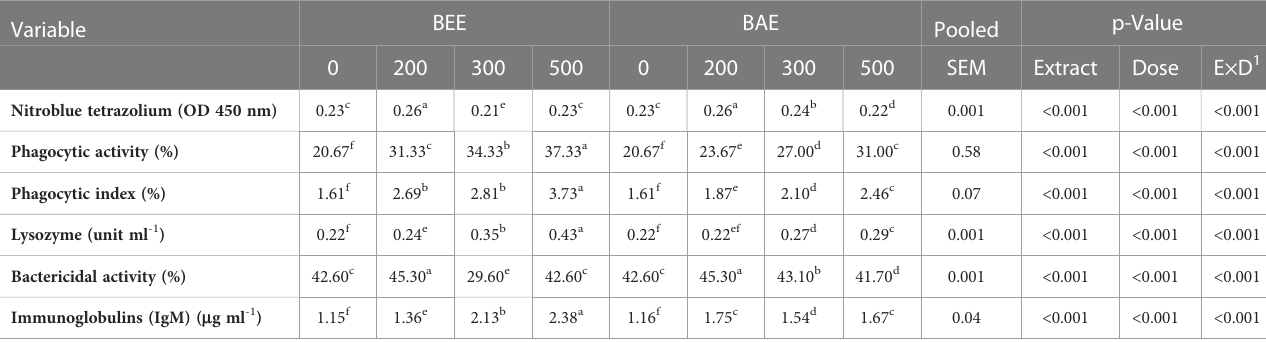
TABLE 6 Effect of dietary supplementation of basil ethanol and aqueous extracts (mg kg -1 of feed) on cellular and humoral immune parameters, and antioxidant status of Nile tilapia, O. niloticus .